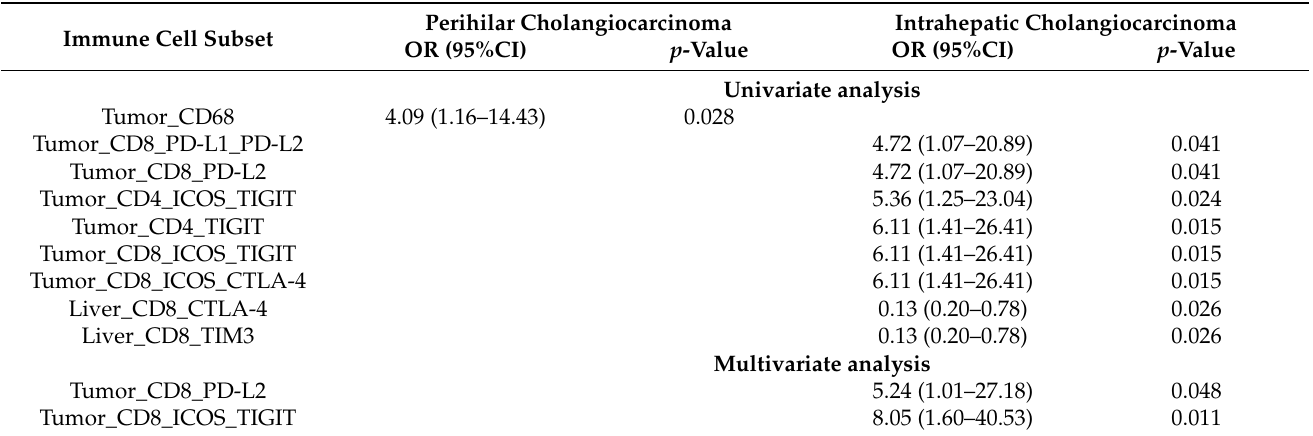
Table 3. Univariate and multivariate binary logistic regression for nodal status in cholangiocarcinoma with respect to immune cell